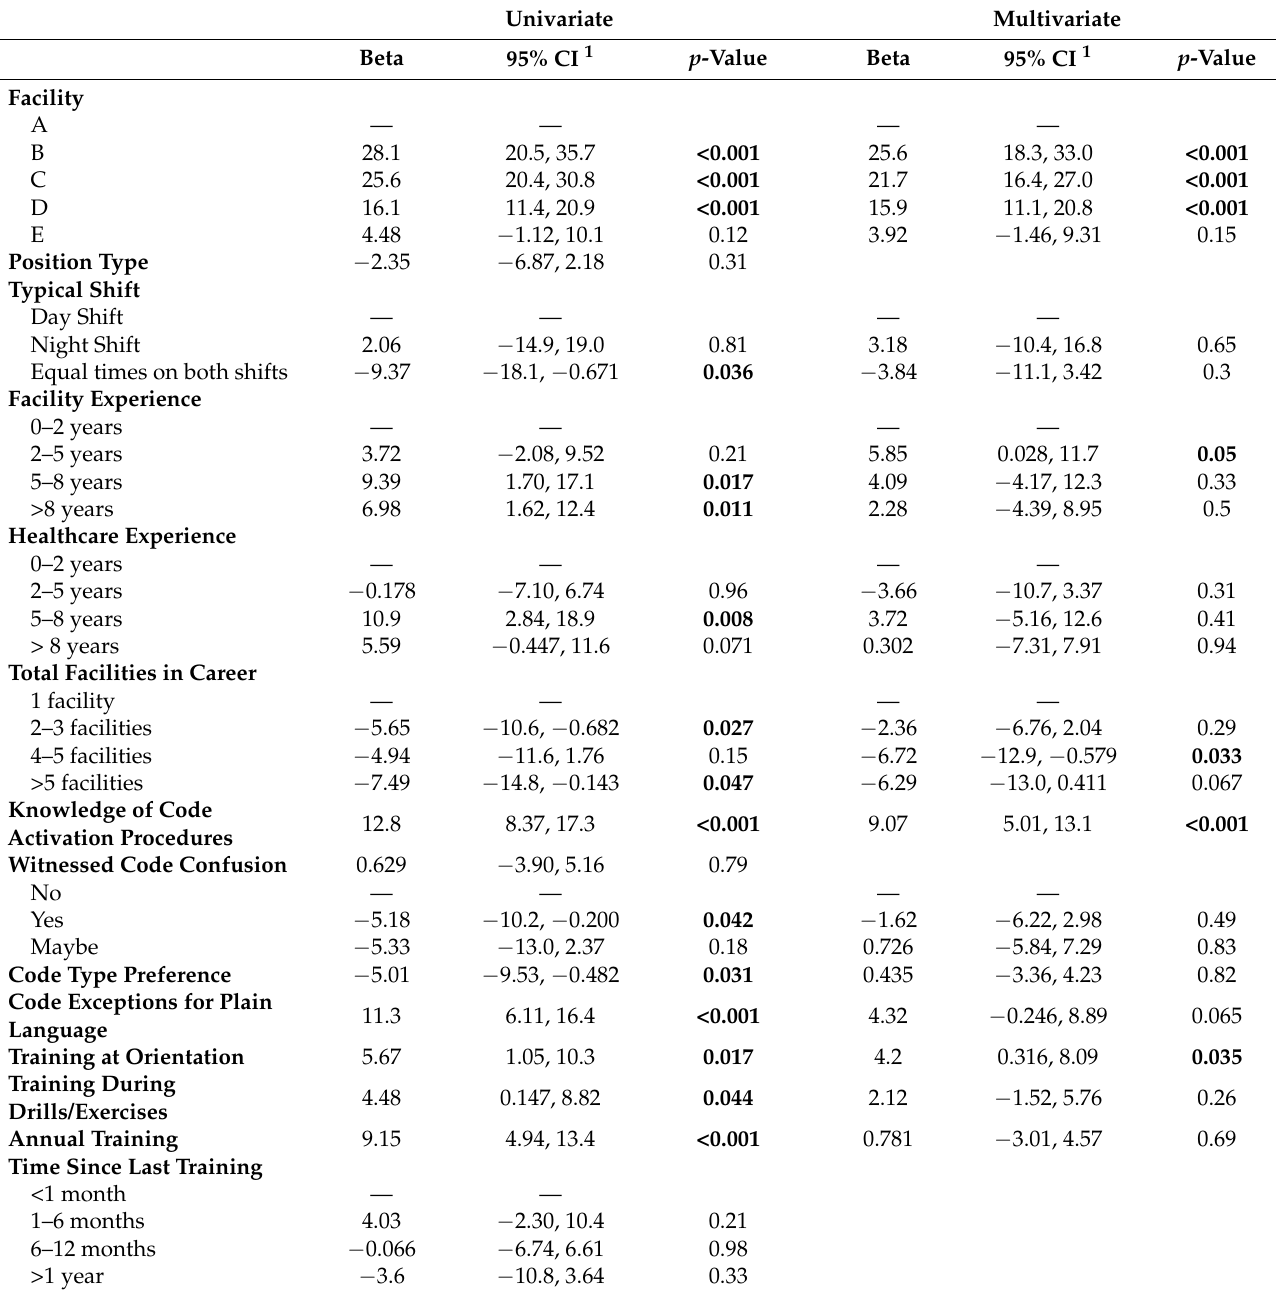
Table 6. Results of regression analyses for code identification score. Significant p -values ( ≤ 0.05) are bolded. Only variables significantly associated with code identification score were included in the multivariate